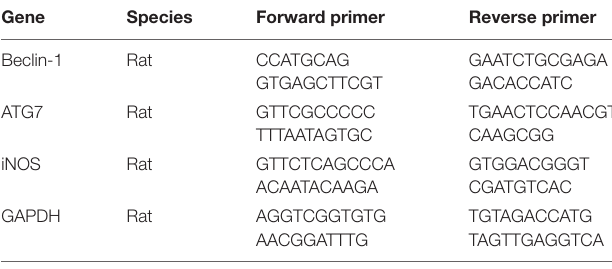
TABLE 1 | List of utilized primers for qRT-PCR.